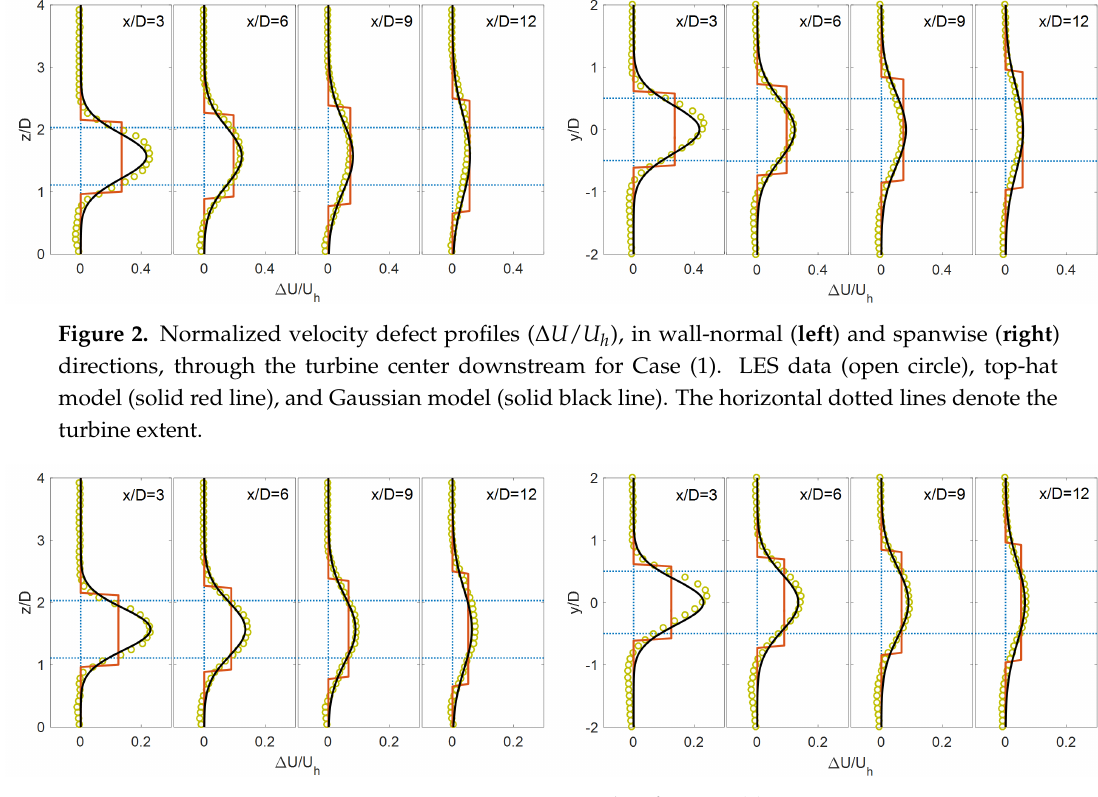
Figure 3. Same as Figure 2 but for Case (2).